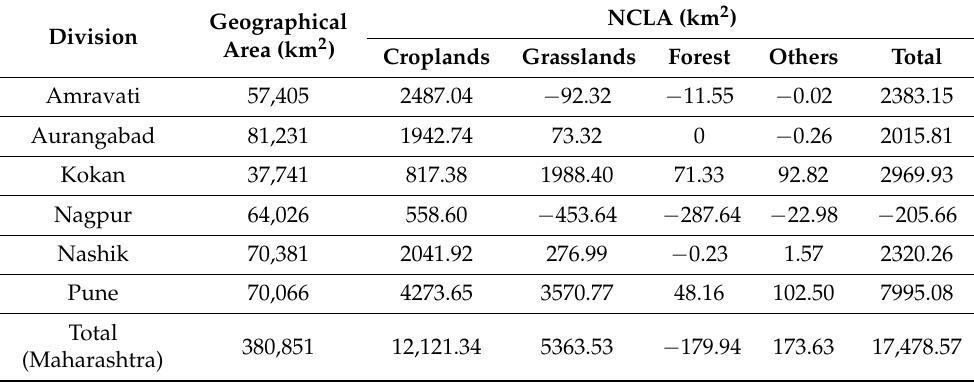
Table 1. Net change in leaf area (NCLA) per division and in each biome based on monthly MK trend analysis during the period of 2003–2004 to 2018–2019. Geographical area (GA) is calculated based on the number of pixels in each division in the static map multiplied by the area of the pixels. NCLA (km 2 ) Geographical Division Area (km 2 ) Croplands Grasslands Forest Others